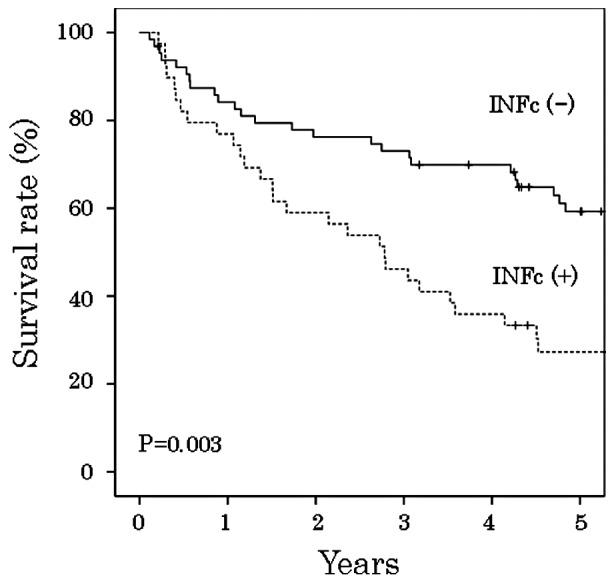
Tumor infiltrative patterns and cumulative survival of patients with lung squamous cell carcinoma. INFc(−)/INFc(+), tumor infiltrative pattern group c component-negative/positive.